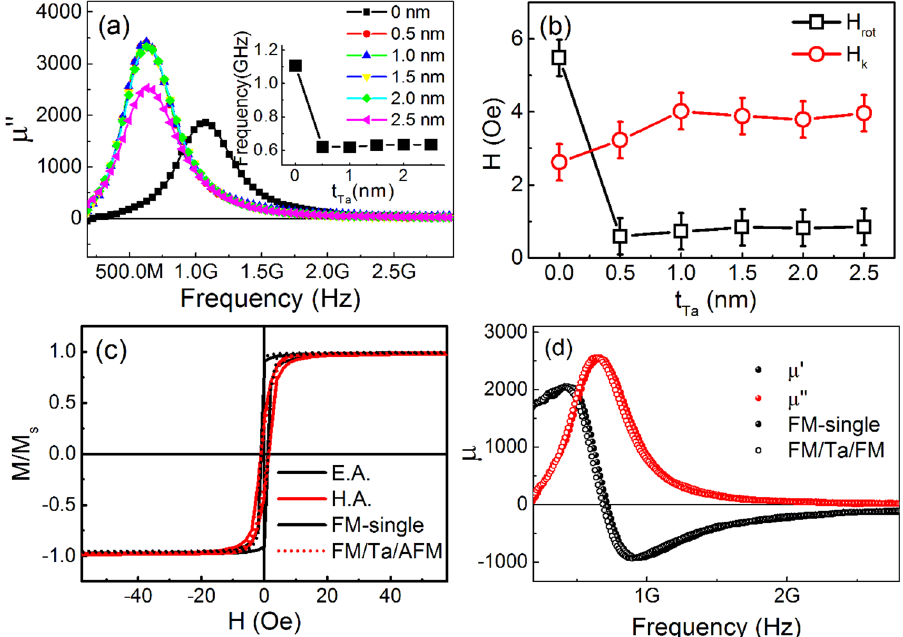
Figure 4. Microwave characteristics of Fe 20 Ni 80 /Ta (x nm)/Fe 50 Mn 50 bilayers. ( a ) Imaginary permeability of Fe 20 Ni 80 /Ta (x nm)/Fe 50 Mn 50 along EA with interlayer thickness of Ta ( t Ta ) ranges from 0 nm–2.5 nm, the insert shows the variation of resonance frequencies as a function of t Ta , ( b ) thickness dependences of H square) and H kdyn (red circle), ( c ) and ( d ) are the hysteresis loops and zero-field permeability of the Fe 20 Ni 80 single layer and Fe 20 Ni 80 /Ta (2 nm)/Fe 50 Mn 50 multilayer,